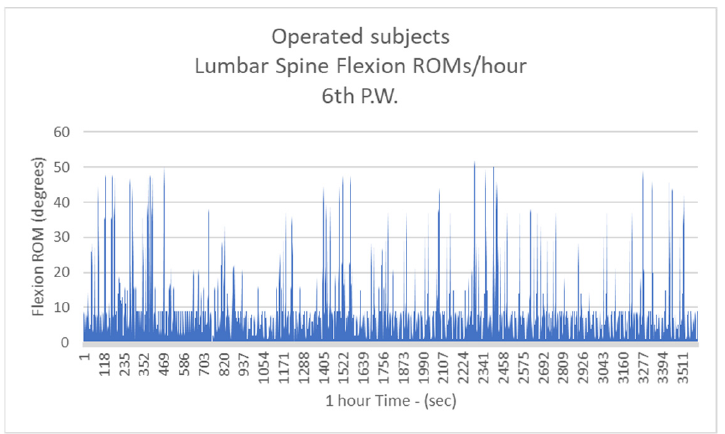
Figure 10. The number of more than 10 degrees of Lumbar Spine Flexions (LSFs) per hour for operated subjects at the 6th postoperative week.